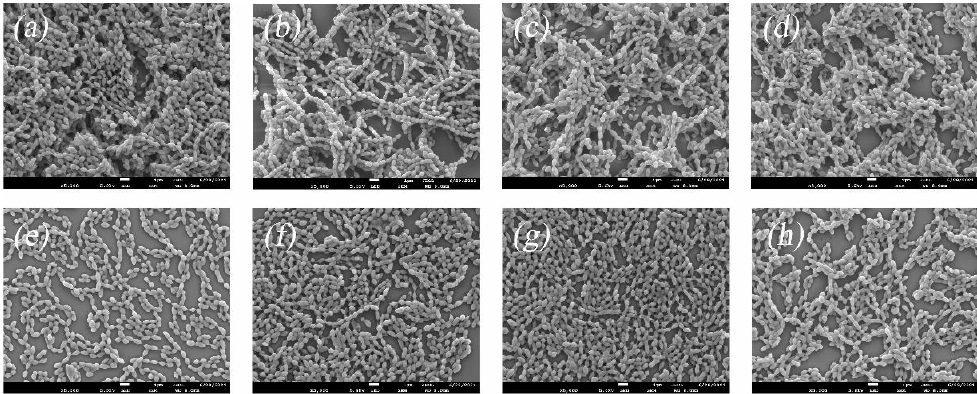
Figure 3. Scanning electron microscopy of S. suis biofilms; scale bars: 1 µm. From ( a ) to ( h ): ( a ): drug free control; ( b ): suffruticosol A; ( c ): suffruticosol B; ( d ): suffruticosol C; ( e ): paeonifloin; ( f ): albiflorin; ( g ): trans- ε -viniferin; ( h ): gnetin